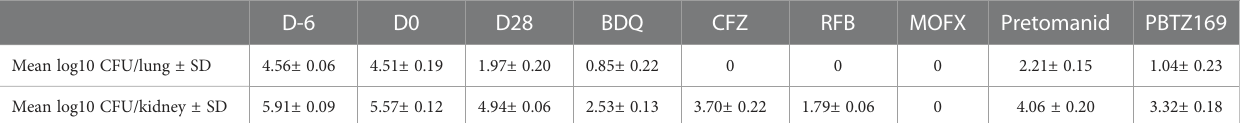
TABLE 6 M. fortuitum burden in the lungs and spleens of mice.